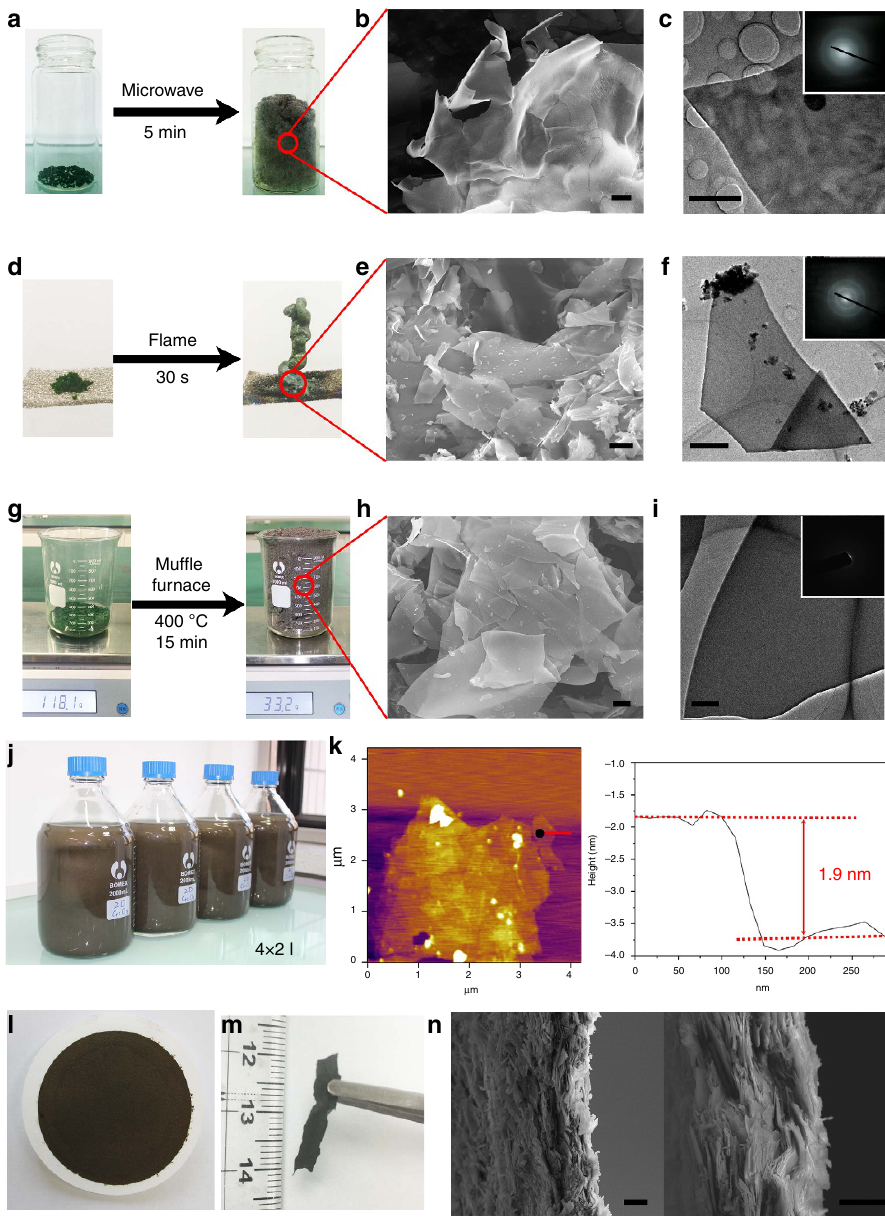
Figure 2 | Nanosheets produced from chromium trichloride hexahydrate. ( a ) A CrCl 3 (cid:2) 6H 2 O sample before (left of panel) and after (right of panel) microwave heating. ( b ) SEM and ( c ) TEM images (inset, corresponding electron diffraction pattern) correspond to the sample in a . ( d ) A CrCl 3 (cid:2) 6H 2 O sample before (left of panel) and after (right of panel) flame heating. ( e ) SEM and ( f ) TEM images (inset, corresponding electron diffraction pattern) correspond to the sample in d . ( g ) A CrCl 3 (cid:2) 6H 2 O sample before (left of panel) and after (right of panel) being heated in the muffle furnace. ( h ) SEM and ( i ) TEM images (inset, corresponding electron diffraction pattern) correspond to the CrCl 3 (cid:2) 6H 2 O sample in g . ( j ) A large quantity (8l) of the 2D Cr 2 O 3 dispersion solution. ( k ) AFM characterization of the Cr 2 O 3 obtained by alcohol lamp heating. ( l ) The 2D Cr 2 O 3 film produced by vacuum filtration. ( m ) The free-standing 2D Cr 2 O 3 film. ( n ) Cross-sectional SEM images of the free-standing 2D Cr 2 O 3 film. Scale bars, 2 m m ( b , c ), 5 m m ( e ), 500nm ( f , i ) and 10 m m ( h , n